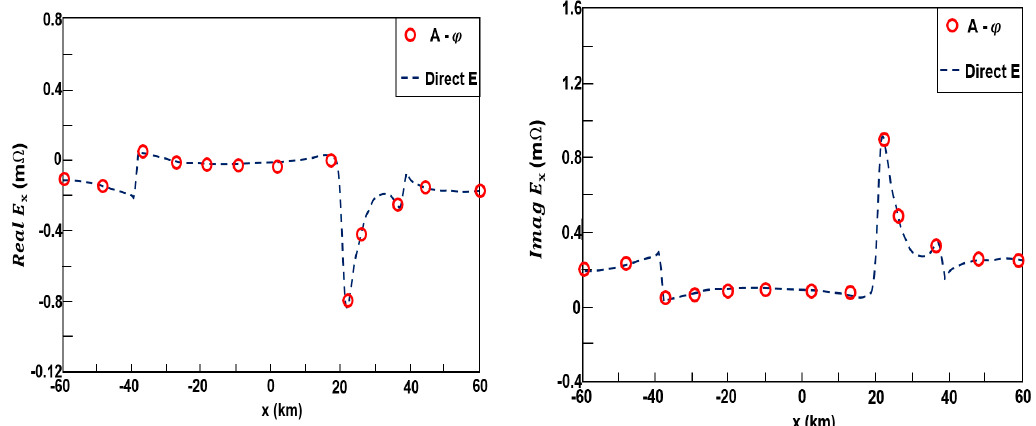
Figure 10. The plot of the real and imaginary component for the normalized electric field of the E x polarization calculated using the Potentials and Direct E formulation.